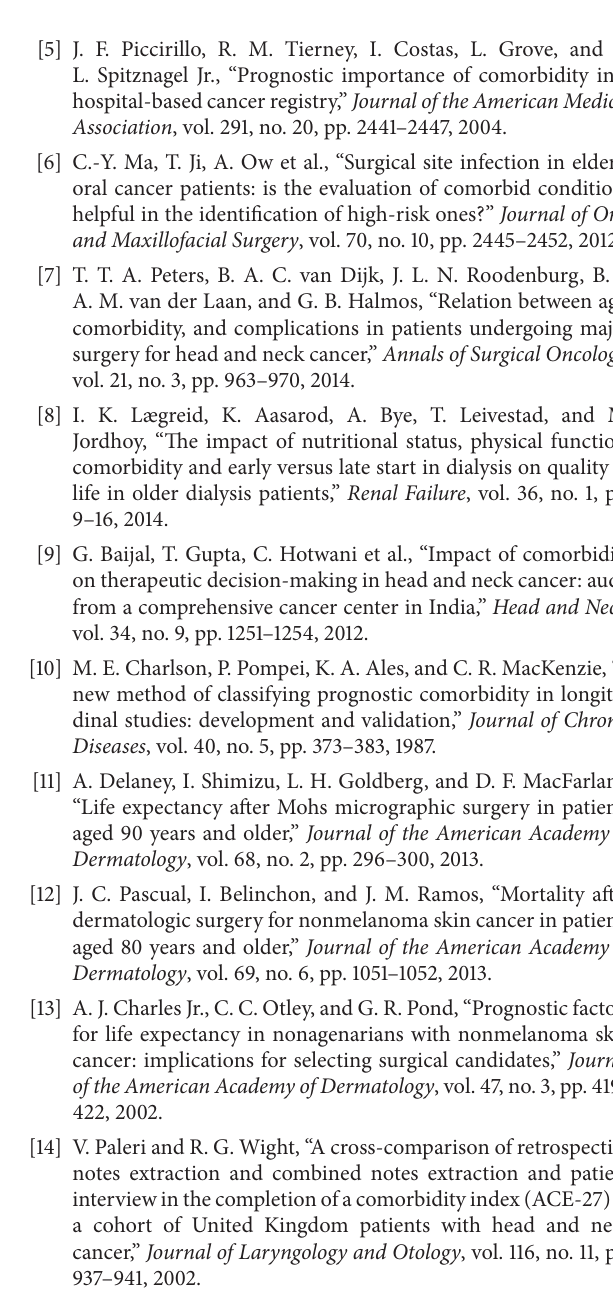
PRACE-27 and MI had identical overall comorbidity scores for 31/44 patients (marked with ∗ ). There were 12 patients for whom PRACE-27 had a higher overall comorbidity score (marked with ∗∗ ) compared to MI and 1 patient (marked with ∗∗∗ ) for whom MI had a higher overall comorbidity score compared to